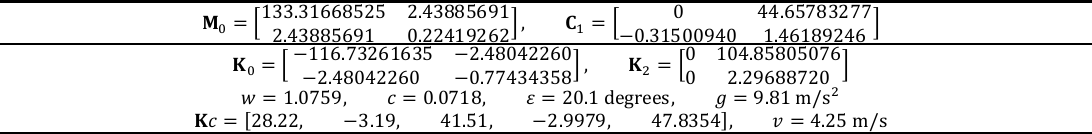
Table A1. Mass, damping and stiffness matrices (1) for the bicycle model from Figure 1, together with some kinematic bicycle parameters; wheelbase w , front wheel trail c , head angle ε , and gravity acceleration g , and rider control feedback gains K c for a forward speeds v ; all in SI units, from